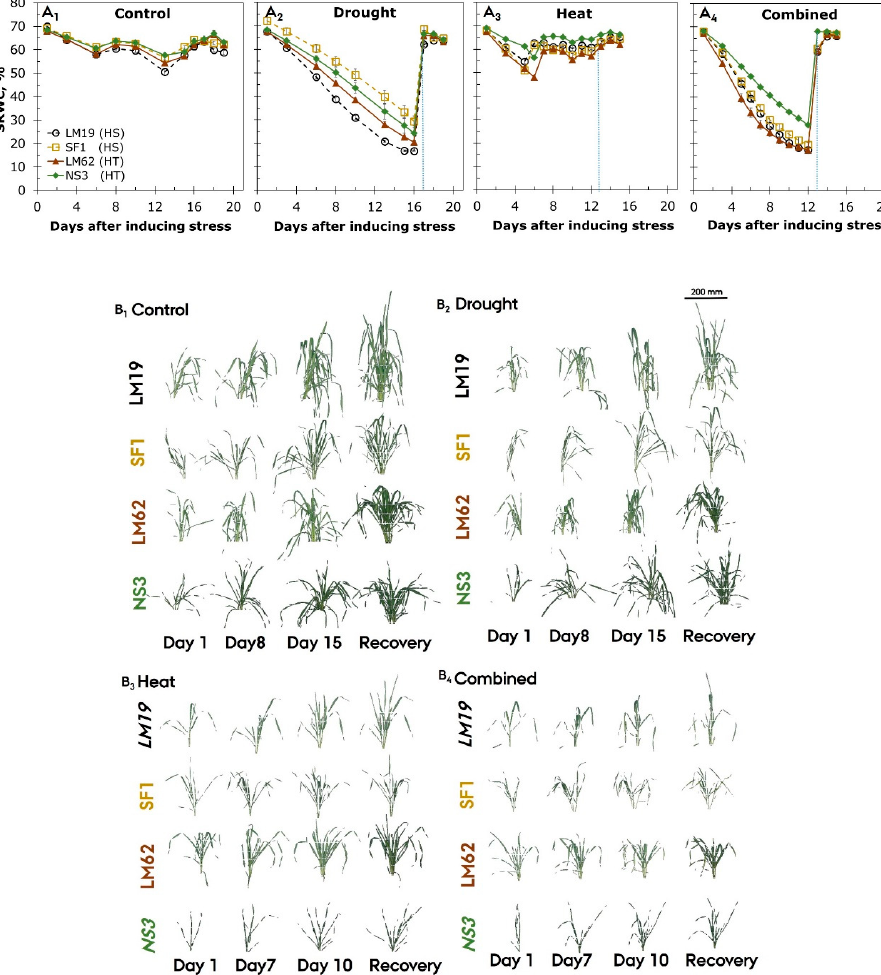
Figure 2. ( A 1–4 ) Soil relative water content (SRWC) at day 1 before inducing the stress and along days after inducing the stress treatments followed by three days of recovery in four wheat genotypes. HS represents heat-sensitive genotypes (open symbols, dashed lines) and HT represents heat-tolerant genotypes (closed symbols, solid lines). Blue dotted line denotes the recovery phase. The data represent mean values ± standard error of mean (S.E.M.) ( n = 5). ( B 1–4 ) RGB images at control, drought, heat and combined stress treatments in four wheat genotypes during day 1, 8, 15 of control and drought stress and day 1, 7, 10 of heat and combined stress and third day of recovery. The plant batches for heat and combined stress in LM19 and NS3 (marked by italic letters) were uninten- tionally given half the growth light up to three days before the start of the stress treatment, which explains their smaller plant size at day 1. The scale bar refers to all RGB images in the figure.